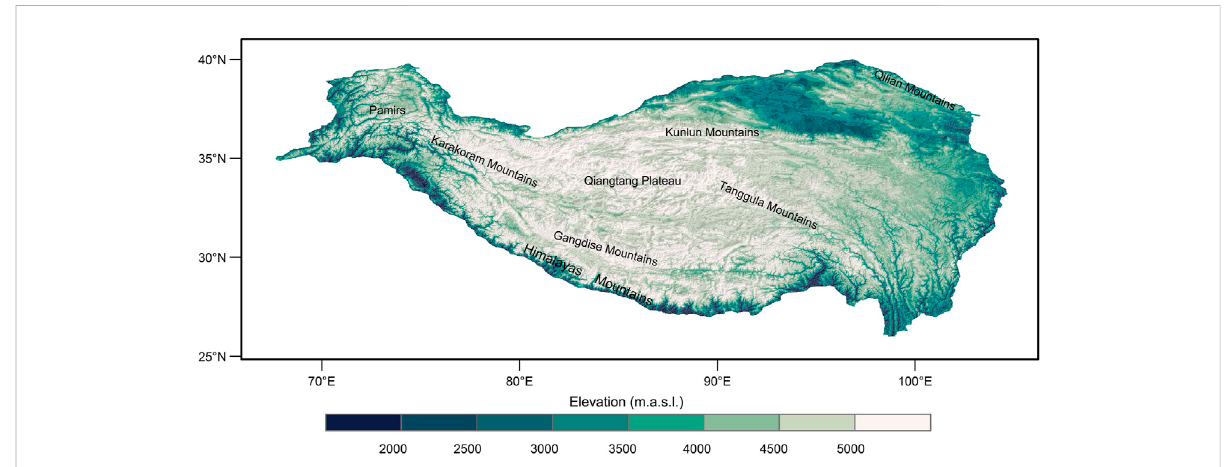
FIGURE 1 The topography (units: m.a.s.l.) of the Tibetan Plateau (TP). The polygon represents the region of TP. The TP boundary data comes from the Scope of Tibetan Plateau Version-2021 (Zhang et al., 2020, the same as